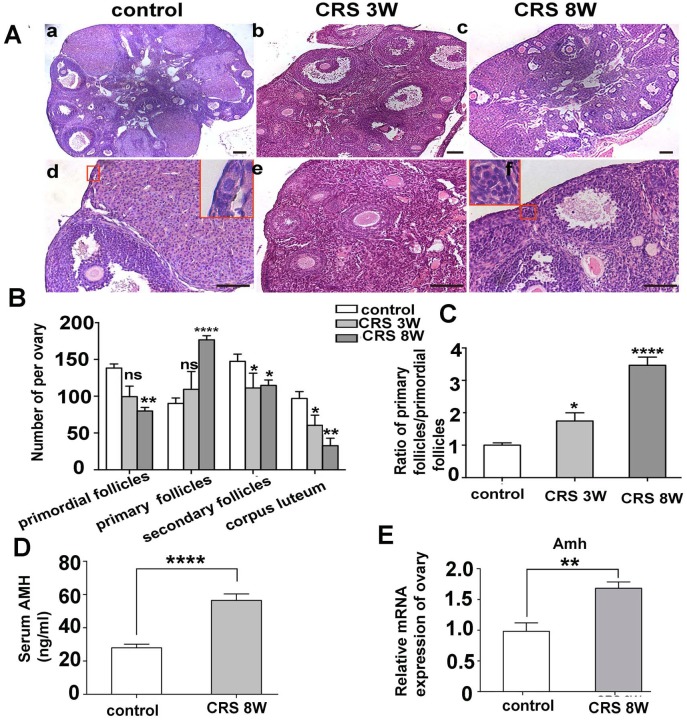
CRS induced activation of primordial follicles and up-regulated the level of AMH.(A)H&E staining morphological features of ovaries derived from the control and CRS groups (scale bar, 100 μm). The red outline showed the enlargements of primordial follicles (d), primary follicles (f) and secondary follicles(b). (B)Effects of 3 or 8 weeks of CRS on different stages of follicles in ovaries removed from adult female BALB/c mice (n = 6). (C) The ratio of primary follicles to primordial follicles in different groups (n = 6). This ratio was 1 for the control group; the data in the CRS group were standardized by the ratio of the control group, and then the odds ratios were calculated and analyzed statistically. (D) The serum AMH level of mice in both the CRS (n = 10) and control groups (n = 15). (E)The mRNA expression level of AMH in mouse ovaries of both the CRS and control groups (n = 6) (*P< 0.05, **P< 0.01, ***P< 0.001, ****P< 0.0001). CRS, Chronic restraint stress.